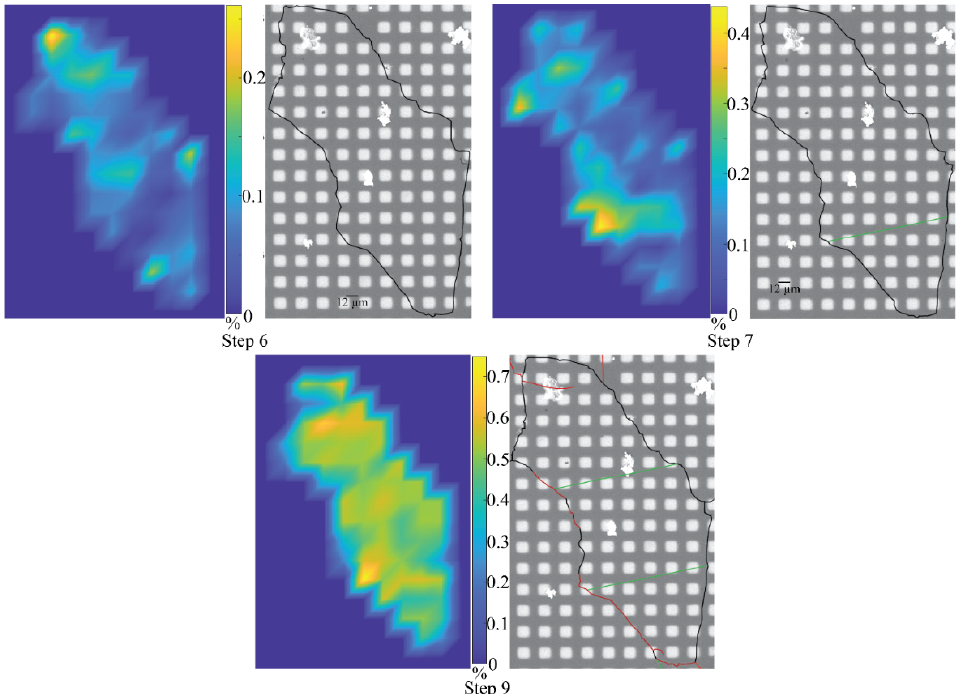
Figure 12. Equivalent Von Mises deformation map of crystal 5 at different steps of sample deformation. The black lines represent the grain boundaries. The green lines show the twinned planes. The red lines show the fracture zones.